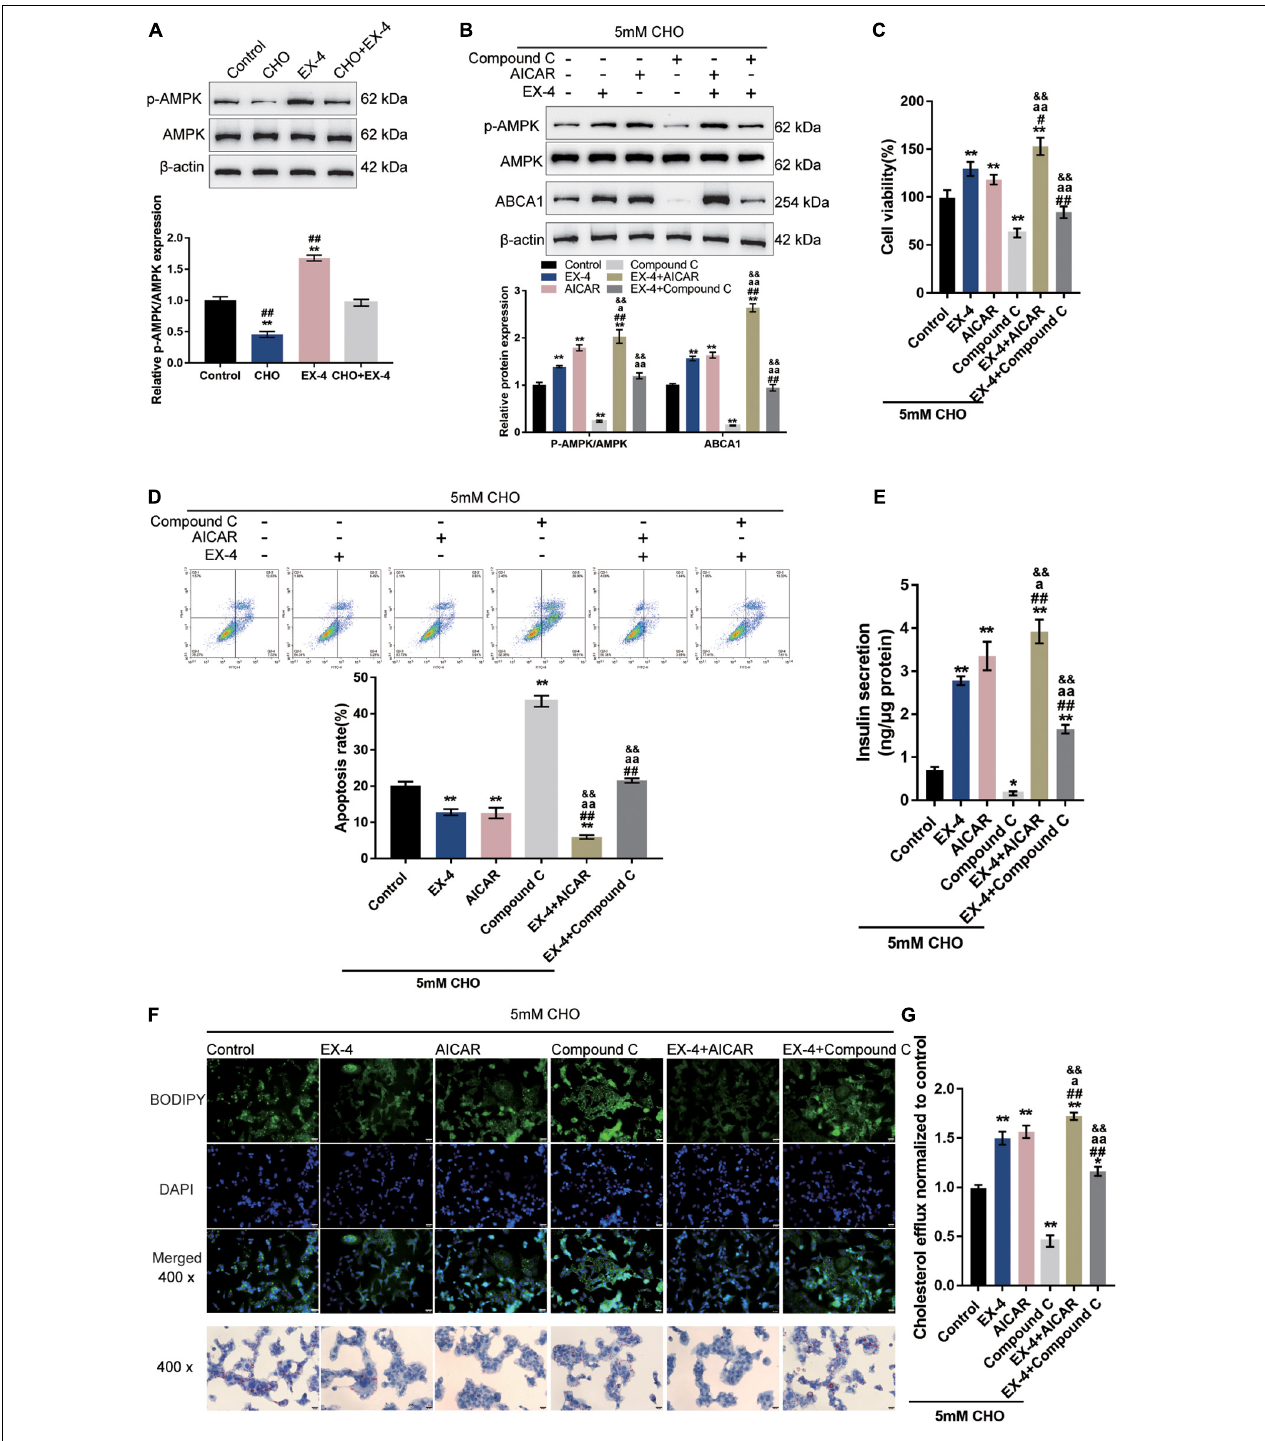
FIGURE 2 | AMPK signaling is involved in GLP-1 regulation of ABCA1 expression and cholesterol-induced toxicity. (A) INS-1 cells were cultured in a medium containing 0 and 5 mM cholesterol in the presence or absence of 10 nM EX-4 for 24 h and examined for the protein levels of p-AMPK and AMPK by immunoblotting. Next, INS-1 cells were treated with EX-4 in the presence of AMPK activator AICAR or AMPK inhibitor Compound C under the stimulation of cholesterol and examined for (B) the protein levels of ABCA1 by immunoblotting; (C) cell viability by MTT assay; (D) cell apoptosis by Flow cytometry; (E) insulin secretion by insulin ELISA kit; (F) intracellular lipid deposition by Oil Red O and BODIPY staining. (G) The cholesterol efflux from INS-1 cells by BODIPY-cholesterol assay; n = 3 for each experiment. * P < 0.05, ** P < 0.01, compared with the control group, # P < 0.05, ## P < 0.01 compared with CHO + EX-4 group, a P < 0.05, aa P < 0.01 compared with CHO + AICAR group, && P < 0.01 compared with CHO + Compound C